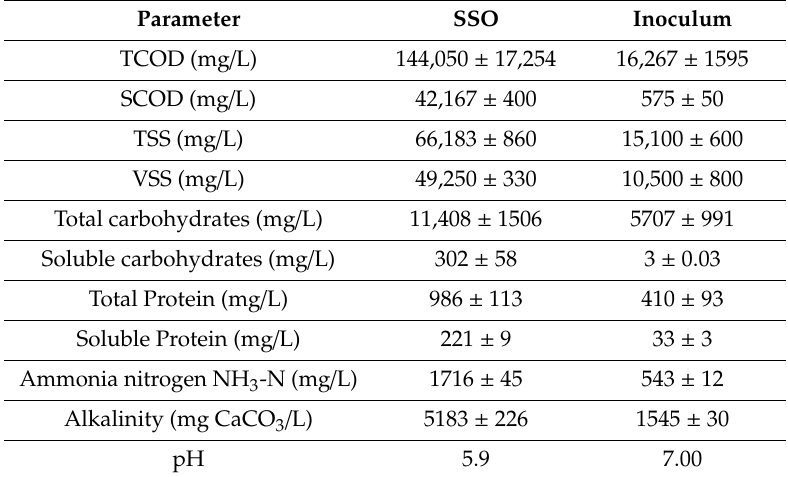
Table 2. Untreated source-separated organics (SSO) and seed inoculum characteristics. Parameter SSO